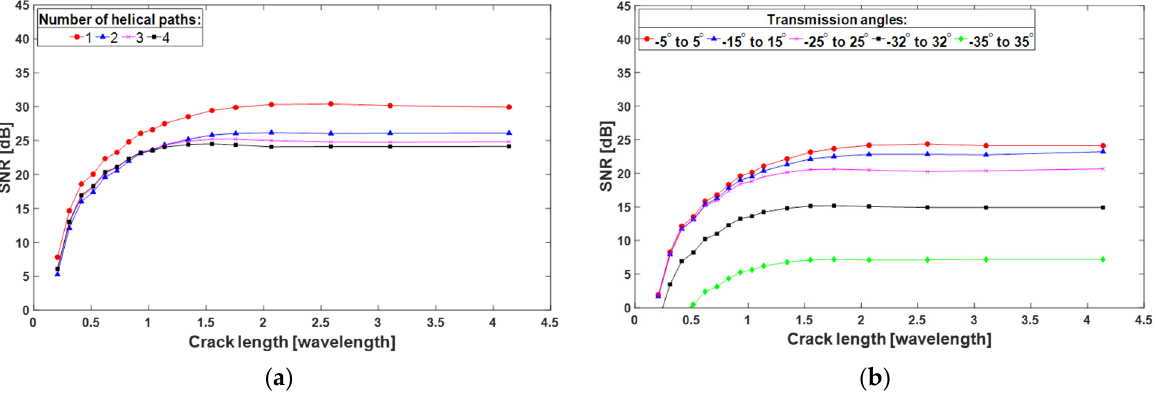
Figure A4. Coherent SNR vs. true crack length measured from ( a ) TFM and ( b ) PWI reconstructions with different angular ranges used on transmission. Based on FE simulations of 50% through wall thickness crack.